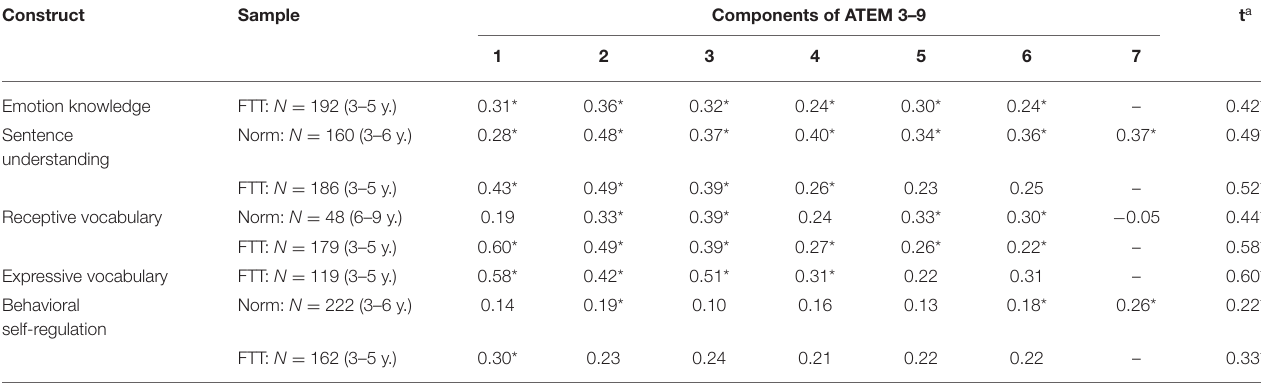
TABLE 8 | Pearson correlations of ATEM 3–9 scores with other constructs, controlled for age and gender. Construct